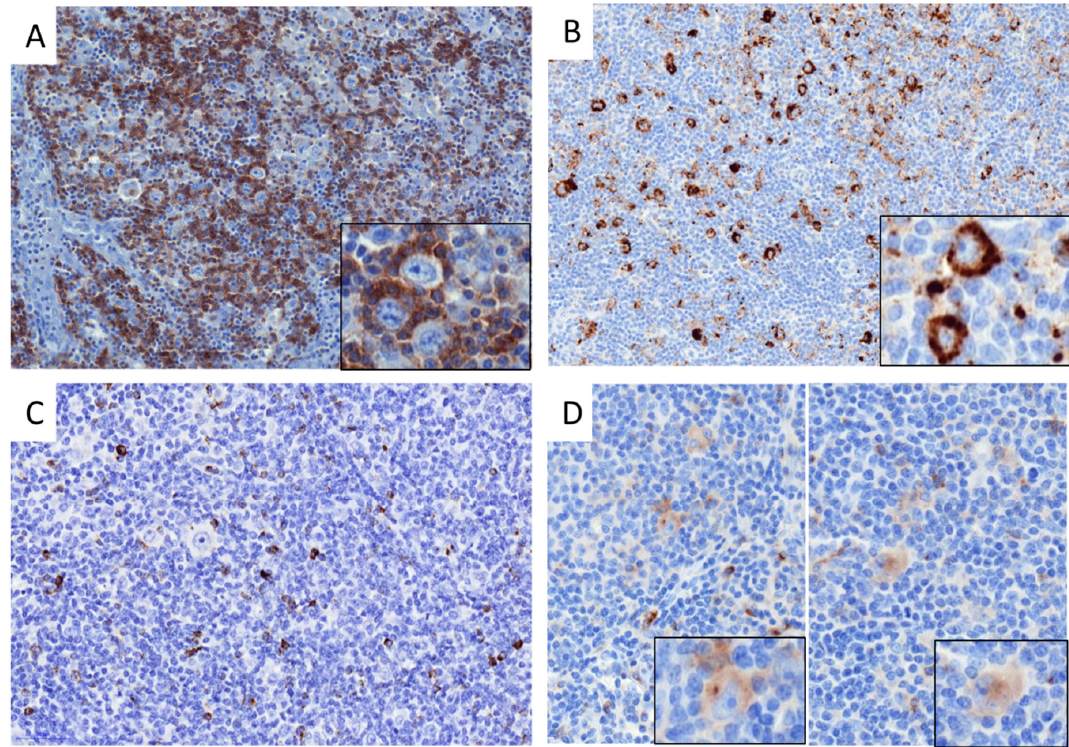
Figure 3. Immune checkpoint staining in classical Hodgkin’s lymphoma and in diffuse large B-cell lymphoma. ( A ) Representative staining of PD-1 in cHL sample showing PD-1 + small lymphocytes around tumor cells (magnification × 200, insert: × 400). ( B ) Representative